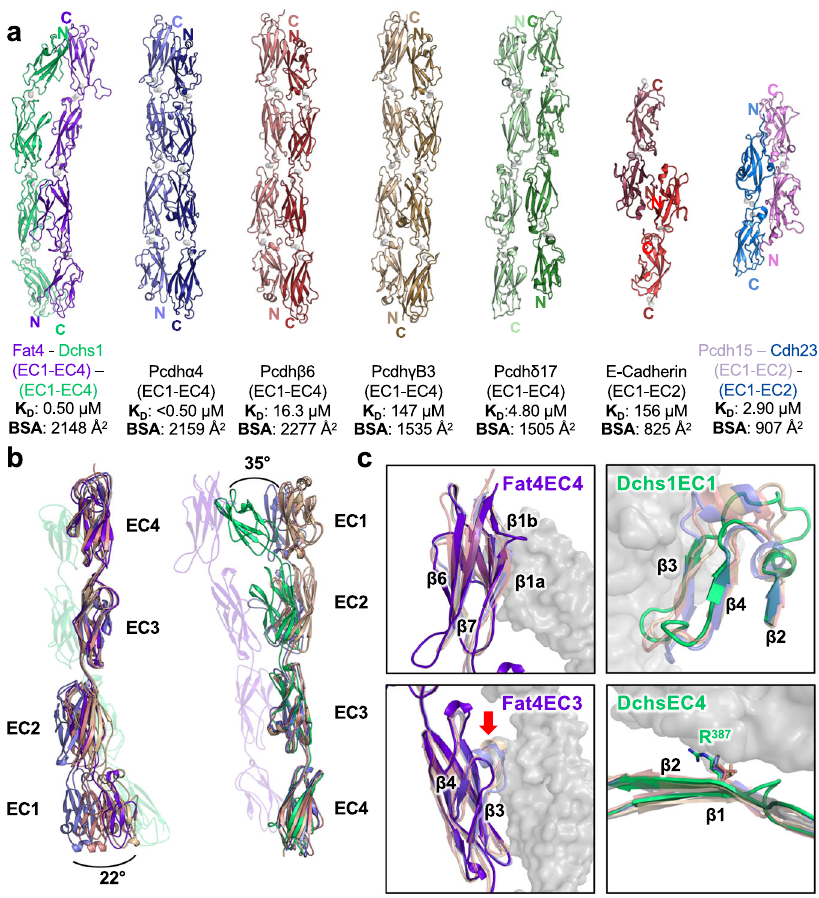
Fig. 4 | Comparison of Fat4:Dchs1, cadherin, and protocadherin structures. a Comparison of the Fat4:Dchs1 structure with structures of selected proto- cadherin homodimers, the E-cadherin homodimer, and the PCDH15:CDH23 het- erodimer.Theburiedsurfaceareaanddissociationorhomodimerizationconstants for each interaction are indicated beneath the structures. b The EC3-EC4 domains of Fat4 or Dchs1 and several protocadherins were aligned to highlight the tilted orientation of Fat4(EC1) and Dchs1(EC1). c Zoom panels showing distinctive